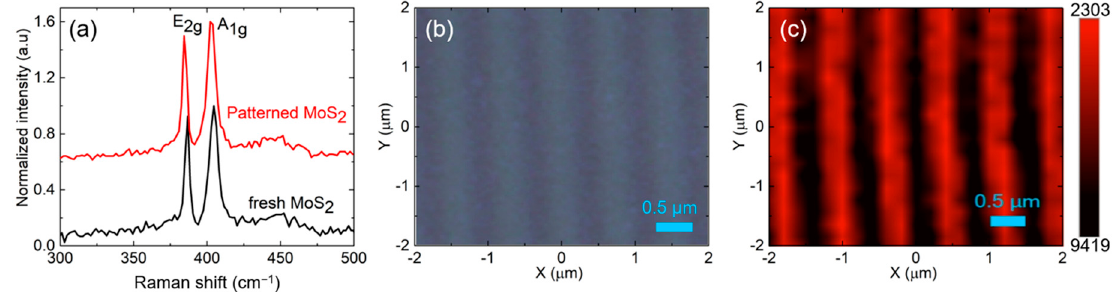
Figure 9. Raman spectra of MoS 2 nanograting. ( a ) Raman shift of MoS 2 on an SiO 2 substrate before and after patterning. ( b ) A microphotograph of an MoS 2 nanograting on an SiO 2 substrate. ( c ) Raman shift mapping of the MoS 2 pattern shown in ( b ) on the SiO 2 substrate.